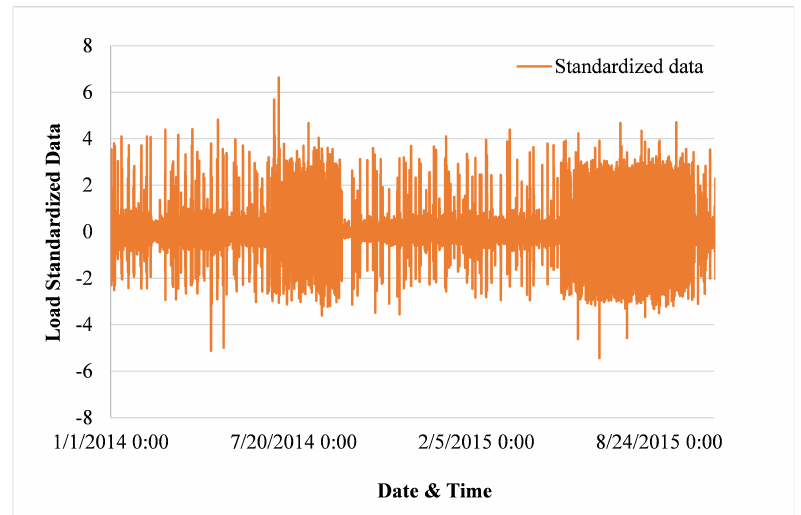
Figure 7. Autocorrelation present in the datasets.